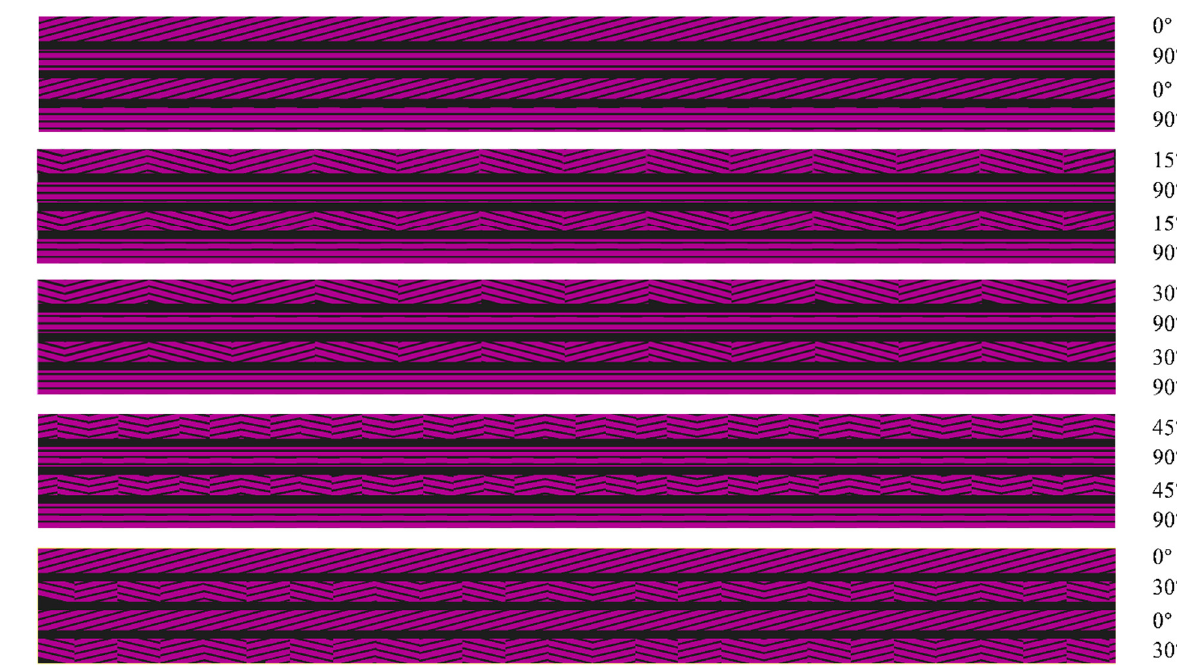
Figure 13. Schematic diagram of different layers of Figure 11. Schematic diagram of different layers of Bio-S.